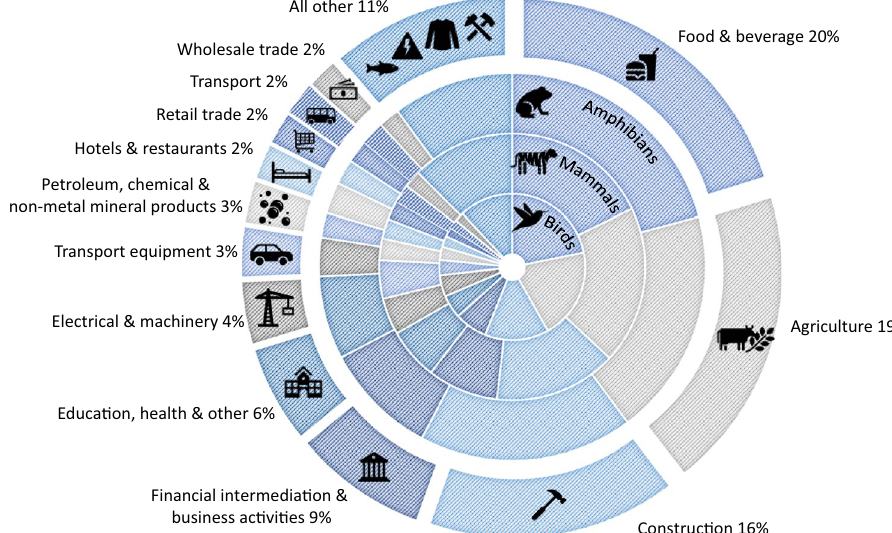
Figure 3. Global extinction-risk footprint by consumption sector. Each sector’s contribution to the global extinction-risk footprint is shown, including a high-level taxonomic breakdown. Country specific sector classifications have been aggregated to 26 common sectors based on the International Standard Industrial Classification. (Generated using Microsoft Excel https:// www. micro soft. com/ en- au/ micro soft- 365/